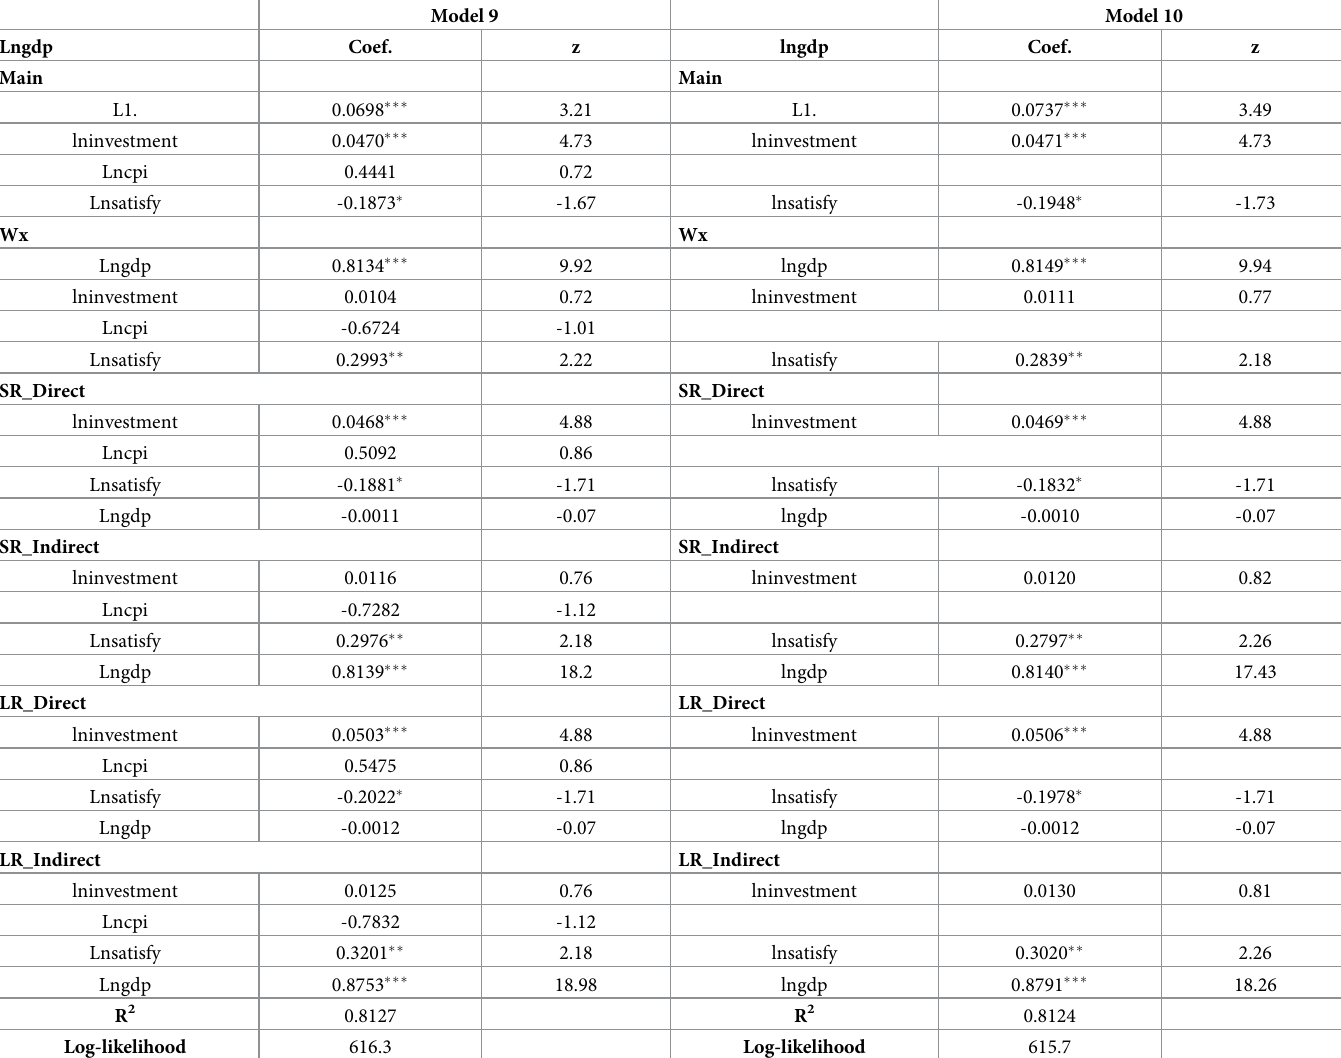
Table 9. SDM_dlag regression results for urban tourist satisfaction and urban